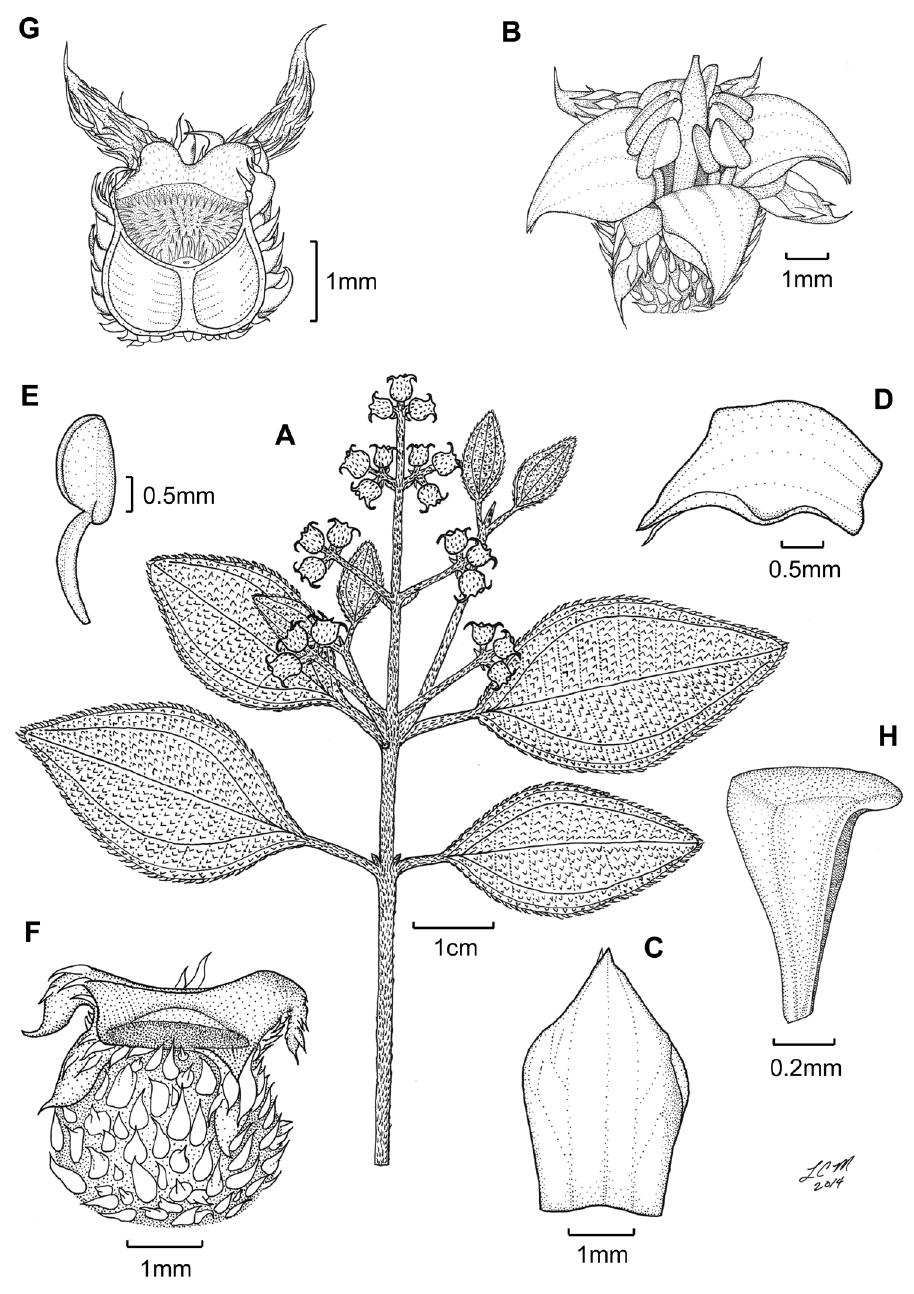
Figure 18. Miconia lima . A habit ( Ekman H1635 ) B flower ( Judd 6587 ) C petal side view ( Clase 935 ) D petal adaxial surface ( Judd 6587 ) E stamen ( Howard 12300 ) F fruit longitudinal section ( Judd 5172 ) G fruit ( Holdridge 1404 ) H seed ( Judd 5172